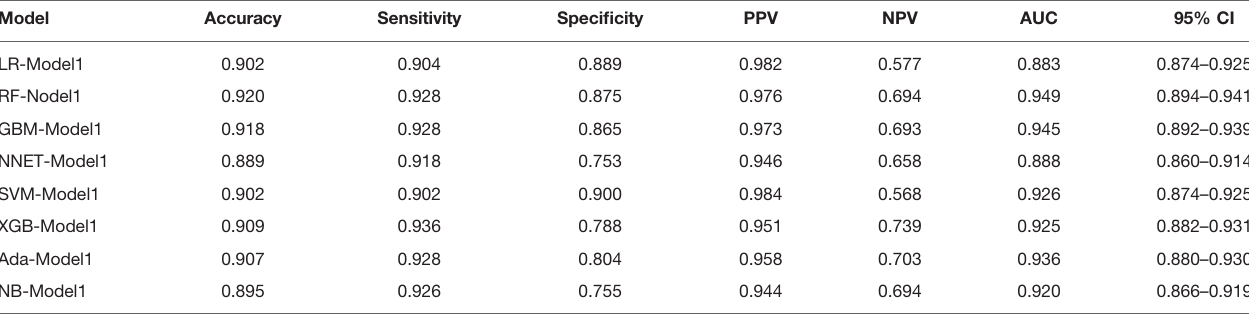
TABLE 2 | Prediction performance of Model1 in the testing